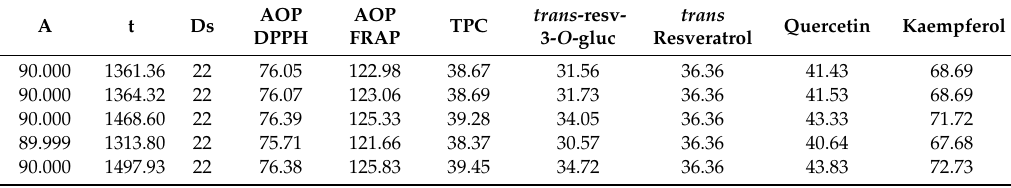
Table 2. The five best optimized conditions of the UA extraction for investigated polyphenolic compounds expressed as a % of increased yields between the UAE and CE for the Merlot